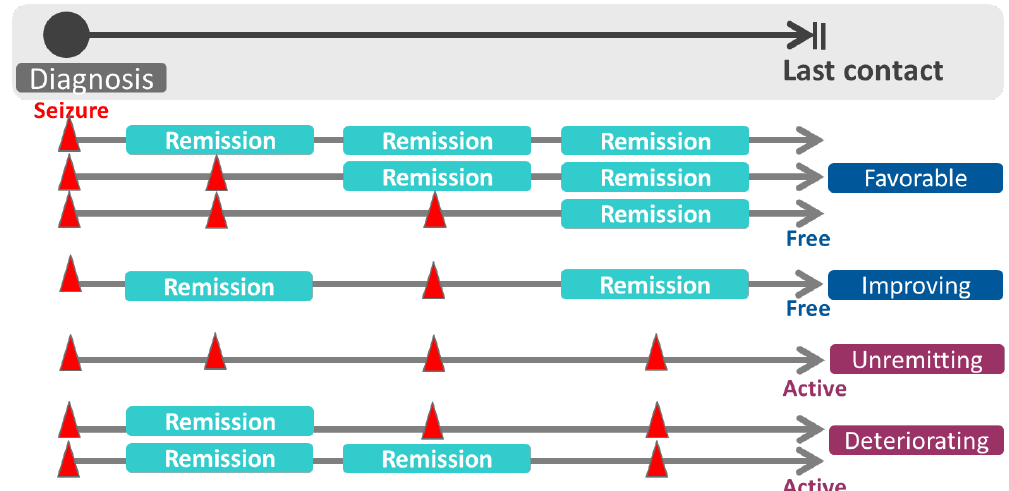
Figure 1. The course of epilepsy categorized by the remission assessed at 2 years, 5 years, and the last year of the follow- up period.